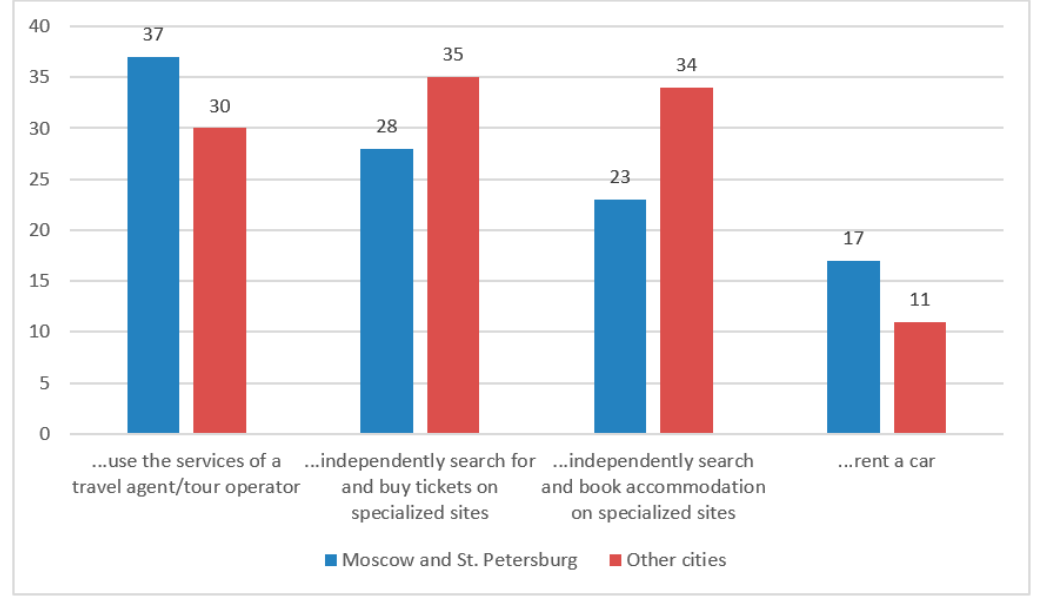
Figure 3. Respondent answers to the question, “If we talk about your upcoming vacation, how likely is it that you...”, by place (NAFI 2019).